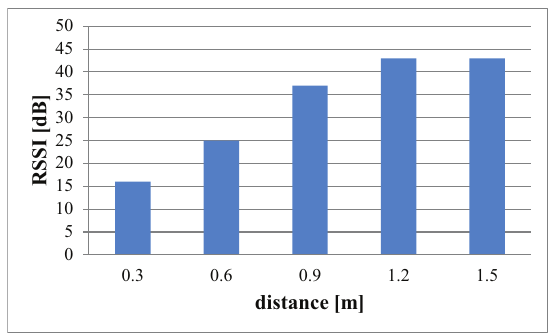
Figure 3. RSS values at different distances in indoor